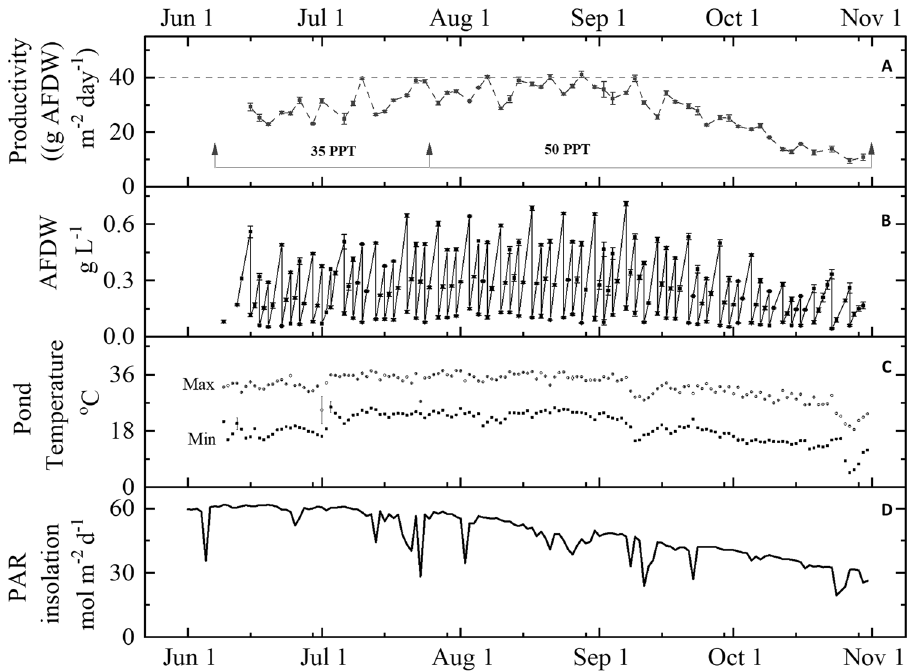
Figure 1. Outdoor pond productivity, temperature and light: ( A ) Harvest-to-harvest average areal biomass productivity, ( B ) volumetric AFDW, ( C ) daily minimum and maximum pond temperatures and ( D ) the daily PAR insolation for the 2020 outdoor field trial. Cultures were grown in nitrogen-replete medium in outdoor ponds located in Mesa, AZ. For areal productivity ( A ) and volumetric biomass concentration ( B ) and pond temperature ( C ), each datapoint represents the average of three ponds (n = 3) and standard error of mean. The period for which media salt concentrations are either 35 PPT or 50 PPT is shown by a horizontal line and arrowheads (in grey) in ( A ). Dotted line in ( A ) denotes 40 g m −2 day −1 . PAR insolation (mol photons m −2 d −1 ) received by the ponds each day over the duration of the outdoor campaigns ( D ).